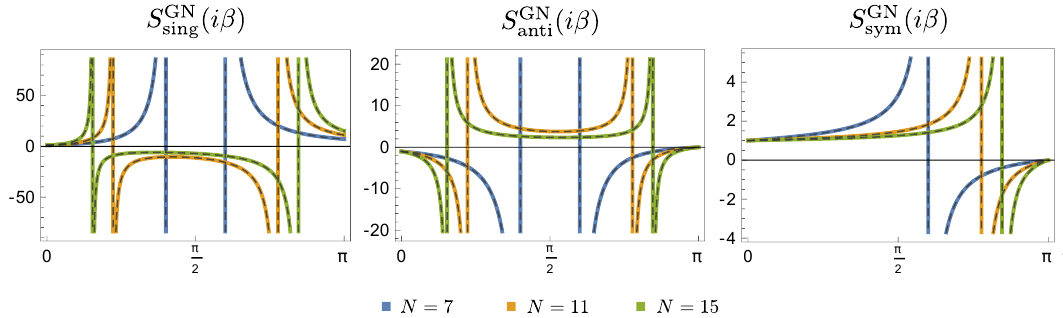
(cid:16) (cid:17) (cid:25) maximizing the N (cid:0) 2